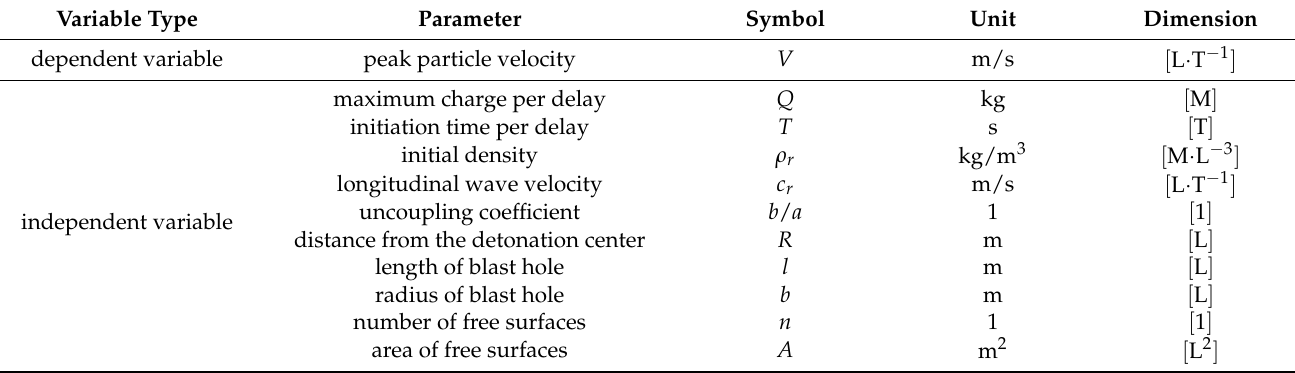
Table 1. Influencing factors of blasting vibration